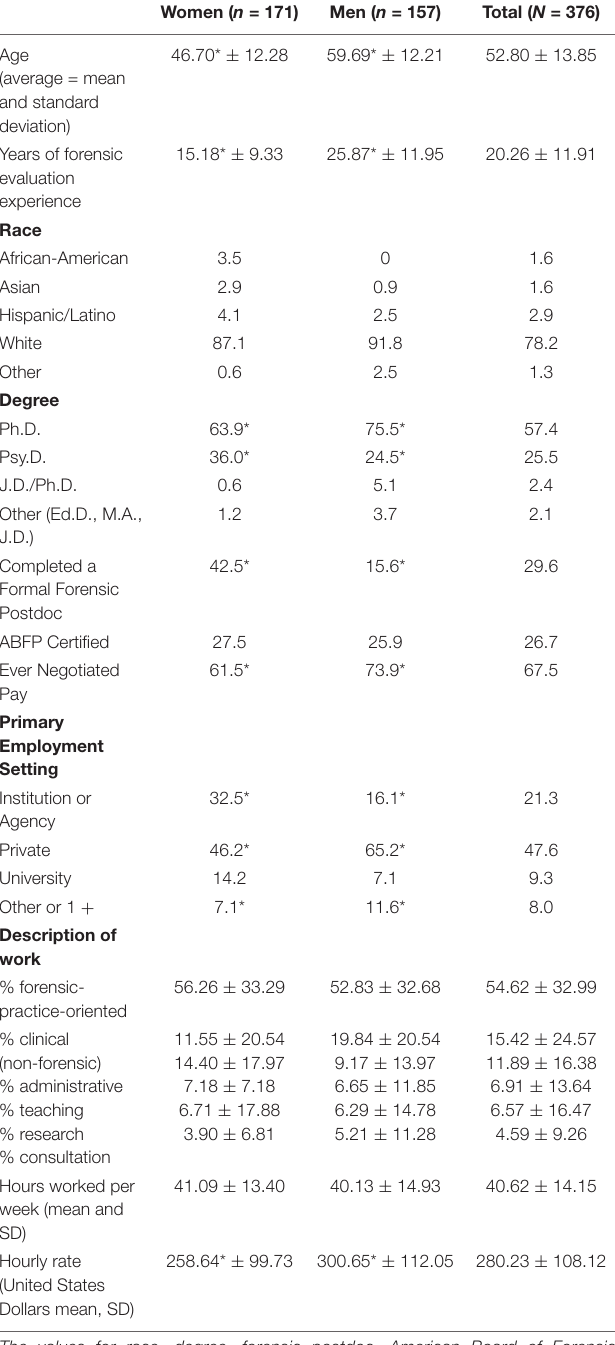
TABLE 1 | Forensic psychologist descriptive statistics with gender